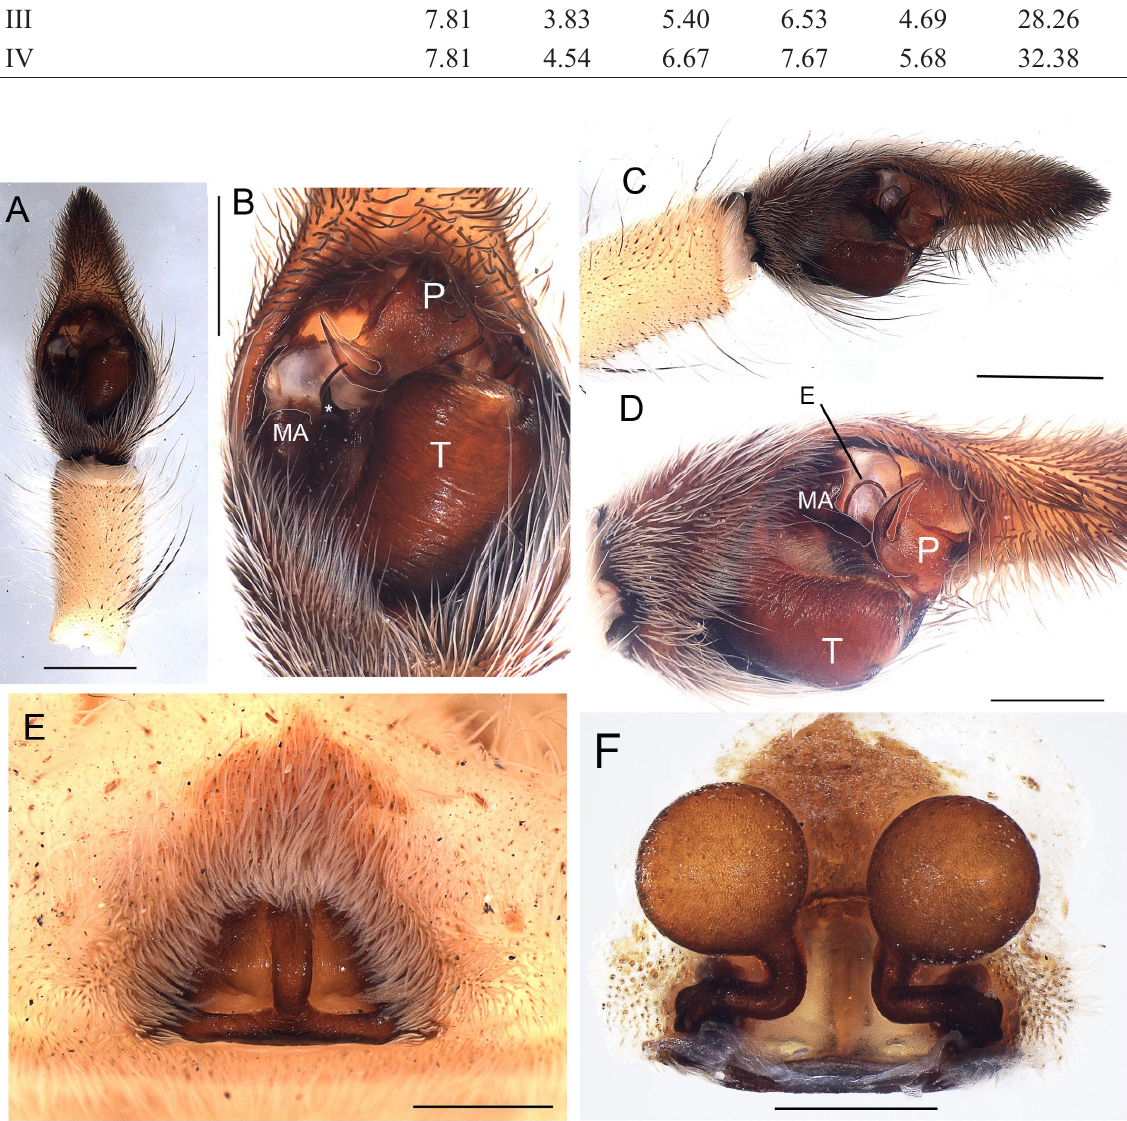
Fig. 5. Ocyale ghost Jocque M. & Jocqué R. sp. nov. A–D . Palp, ♂, holotype. A . Ventral view. B . Same, detail. C . Lateral view. D . Same, detail. E–F . Epigyne, ♀, paratype (MRAC 245338). E . Ventral view. F . Digested, dorsal view. Abbreviations: MA = median apophysis; P = palea; T = tegulum; E, * = embolus. Scale bars = 0.5